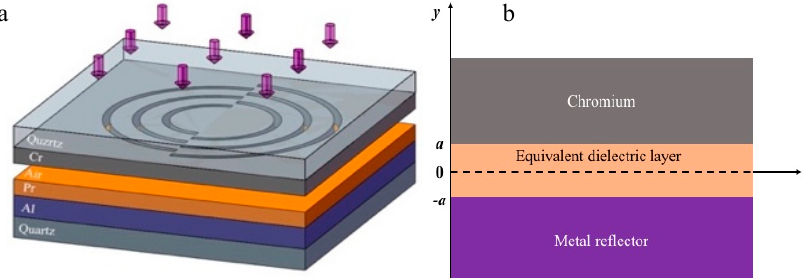
Figure 2. Configuration of the metal-insulator-metal (MIM) heterostructure in the rotational near-field photolithography (RNFP) system ( a ), and its longitudinal section ( b ).